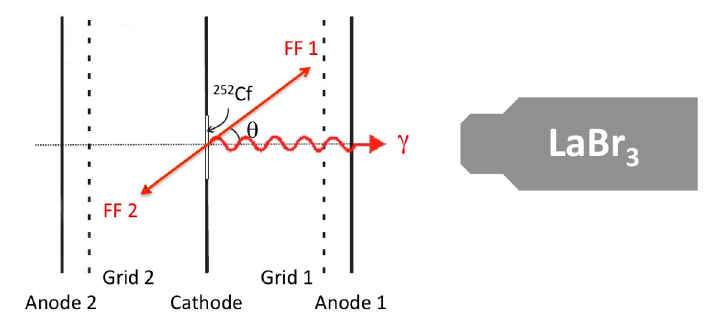
Figure 1. Sketch of the experimental setup used to measure angular correlations between fission frag- ments (FF 1 or FF 2) and prompt fission γ rays. The fragments were detected with a cylindrical twin Frisch-grid ionization chamber (FGIC) on whose central cathode a 252 Cf sample was mounted. For the detection of the γ rays a LaBr 3 :Ce detector of size 76 mm × 76 mm was employed that was placed along the symmetry axis perpendicular to the sample. The polar angle of the emitted fragments equivalent to the angle relative to the detected photons is denoted by θ